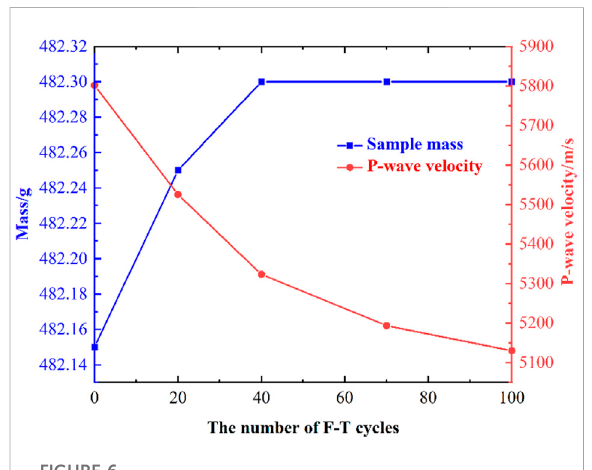
FIGURE 6 Mass and P-wave velocities of granite subjected to different numbers of F – T cycles.